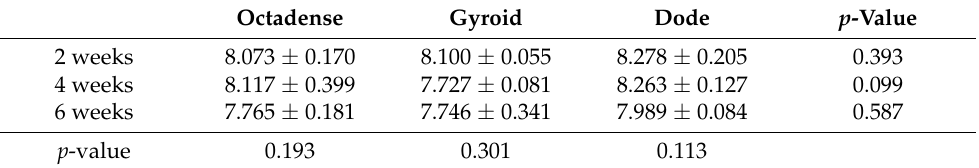
Table 2. Surface density of new bone (mm 2 /mm 3 ) of 3D-printed porous titanium with variable pore